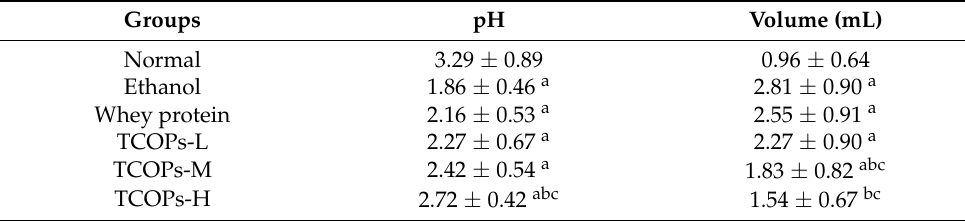
Table 3. Effect of TCOPs on gastric juice in